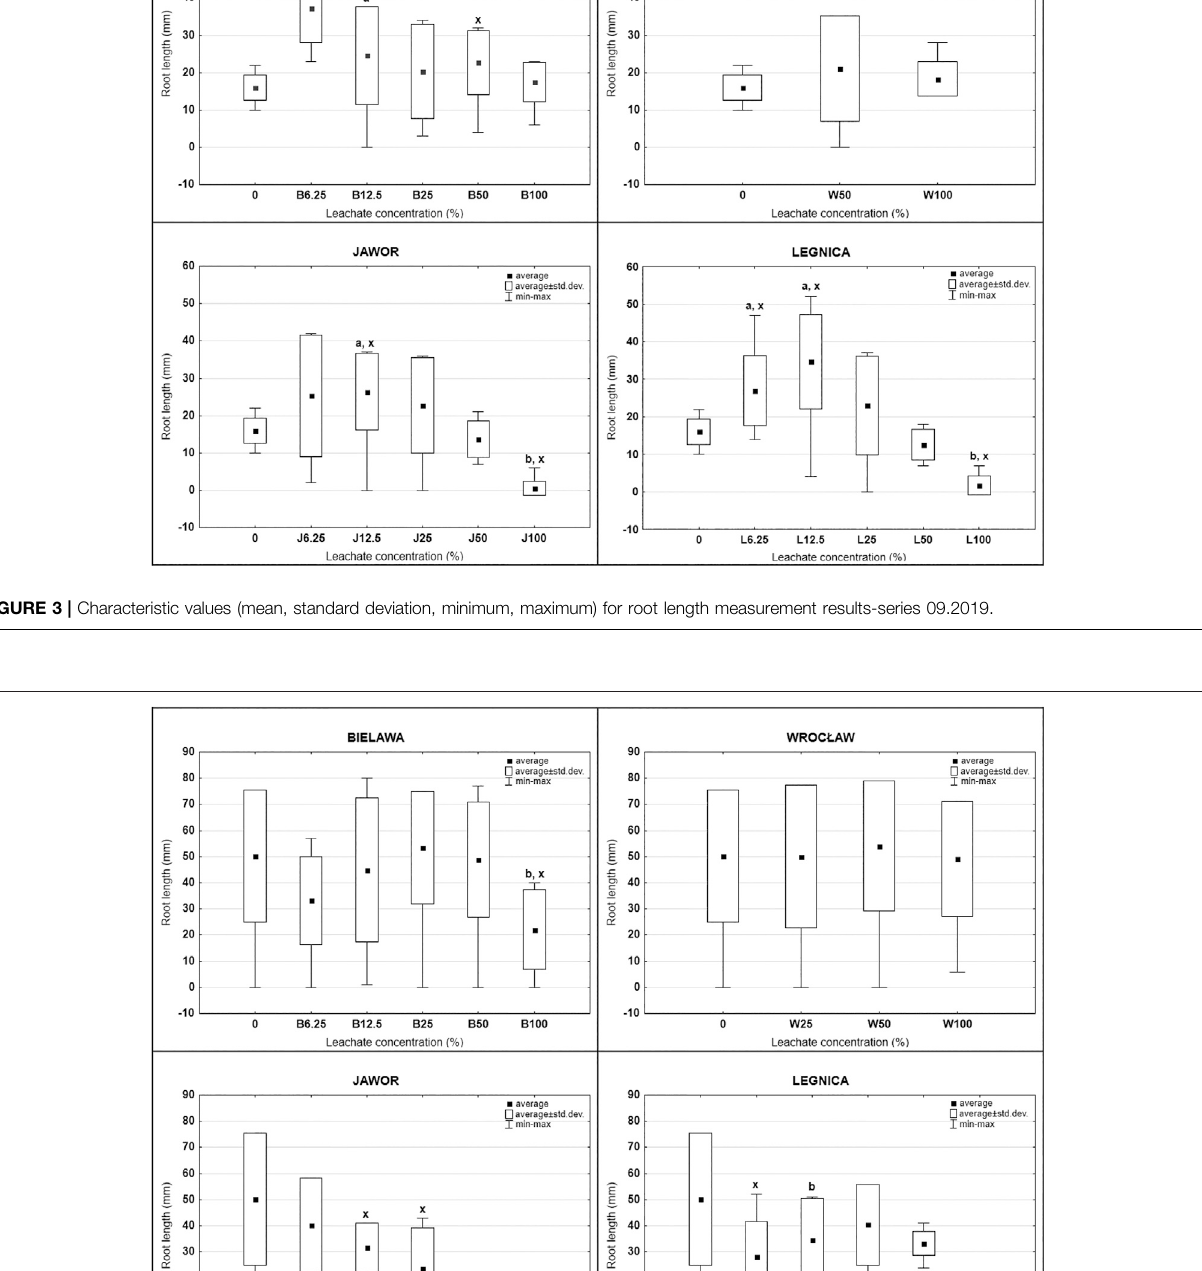
Frontiers in Environmental Science |